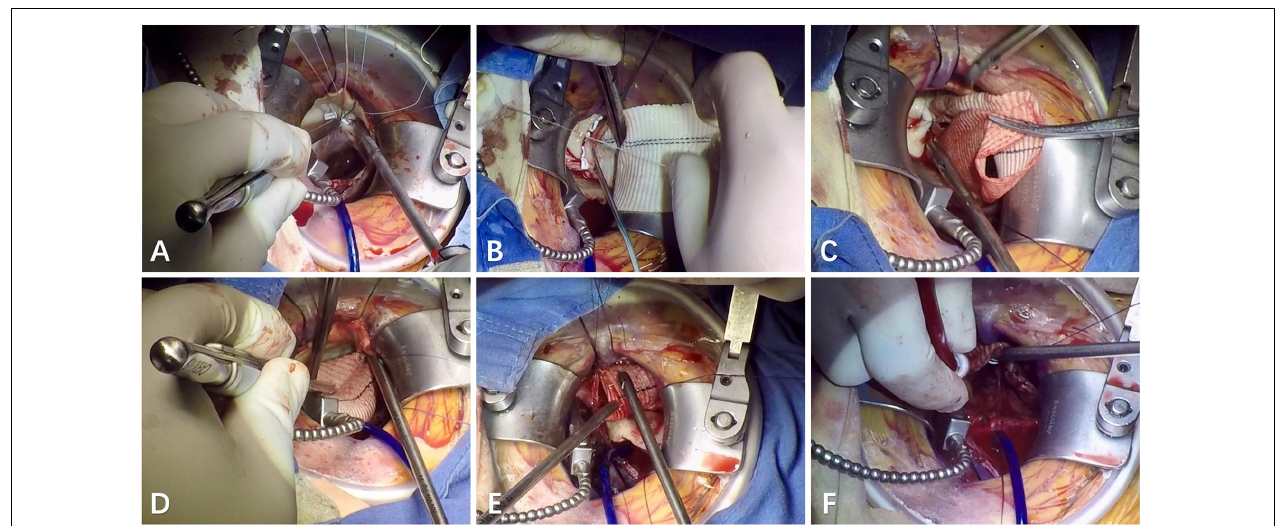
FIGURE 1 | Right minithoracotomy Bentall procedure. (A,B) The images show the annular sutures using a double-armed 2–0 poly (ethylene terephthalate) suture with gasket and an interrupted mattress suturing technique; (C) the image shows the anastomosis of the left main coronary-graft with a running fashion using 5–0 polypropylene; (D) the image shows the anastomosis of the right main coronary-graft with a running fashion using 5–0 polypropylene; (E) the image shows the distal anastomosis of graft-native ascending aorta with a running fashion using 4–0 polypropylene; (F) the image shows that the left ventricle and the graft were de-aired with a venting needle in the root of the aorta before the cross clamp was